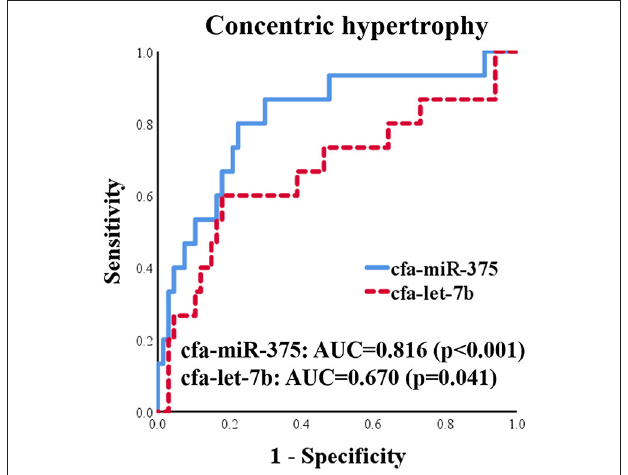
FIGURE 8 | ROC curves for cfa-miR-375 and cfa-let-7b to distinguish dogs with concentric cardiac hypertrophy from dogs without concentric cardiac